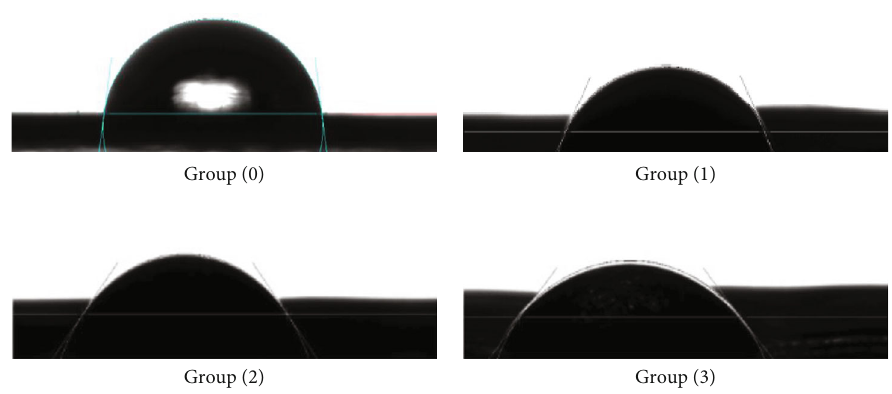
Figure 6: Representative experimental images of contact angles of PVDF-coated fabrics. Table 4: Contact angle evolution of experimental PVDF-coated